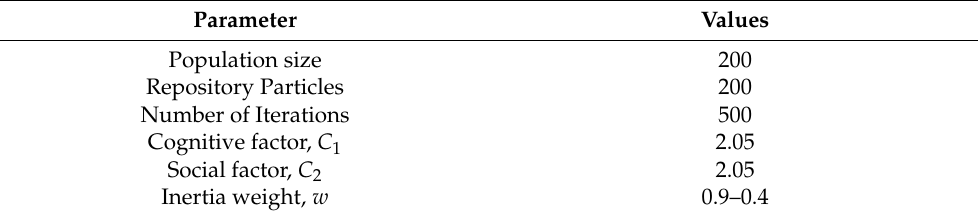
Table 2. PSO Parameters [47].